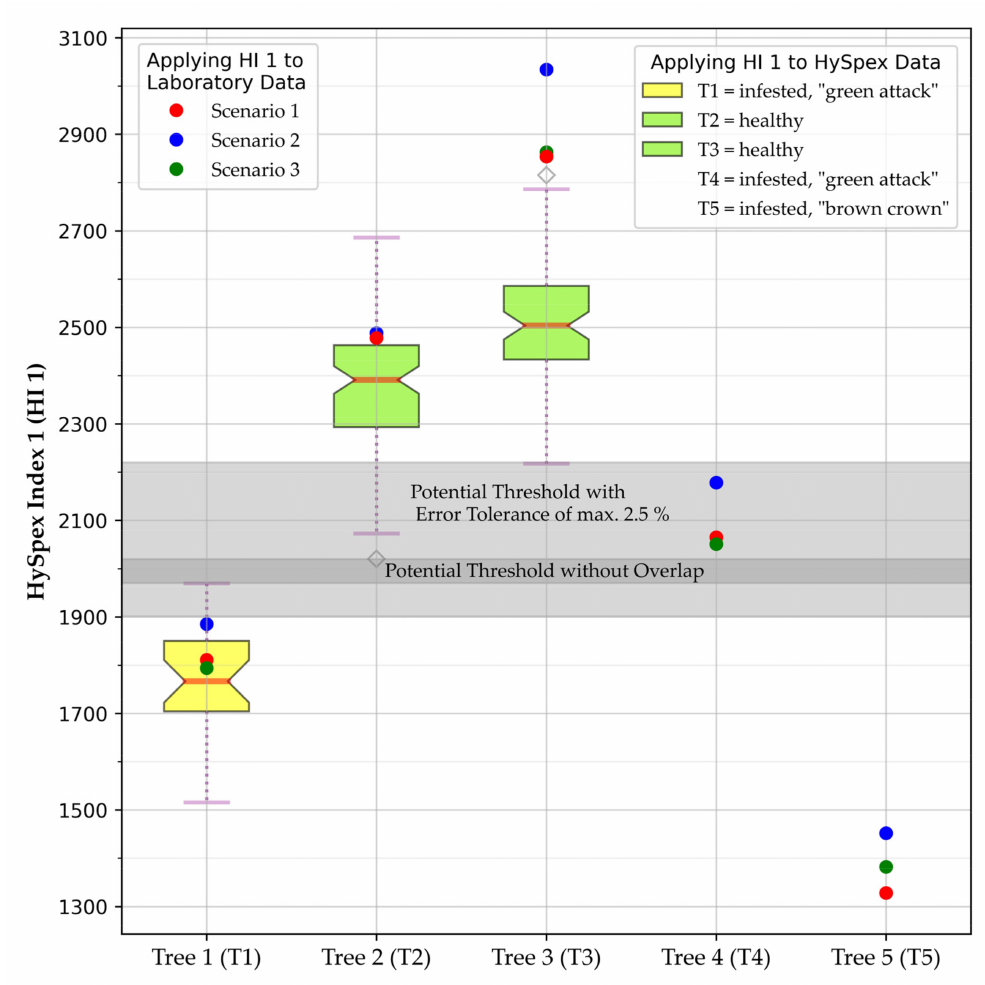
Figure 10. Application of HySpex index 1 (HI 1) to the HySpex data and laboratory data (reflectance [% × 1000]). The mean values of the three scenarios of the laboratory data are within the range of values of the HySpex data for T1 and T2 and outside for T3. The mean values of the laboratory data of T4 and T5 can indicate the approximate values of T4 and T5 of the HySpex data. With the help of a threshold value (1970–2020), it is possible to differentiate between healthy and infested spruces for HI 1 when applied to the HySpex data. By accepting a small error tolerance (max. 2.5%), the value range of this threshold increases to